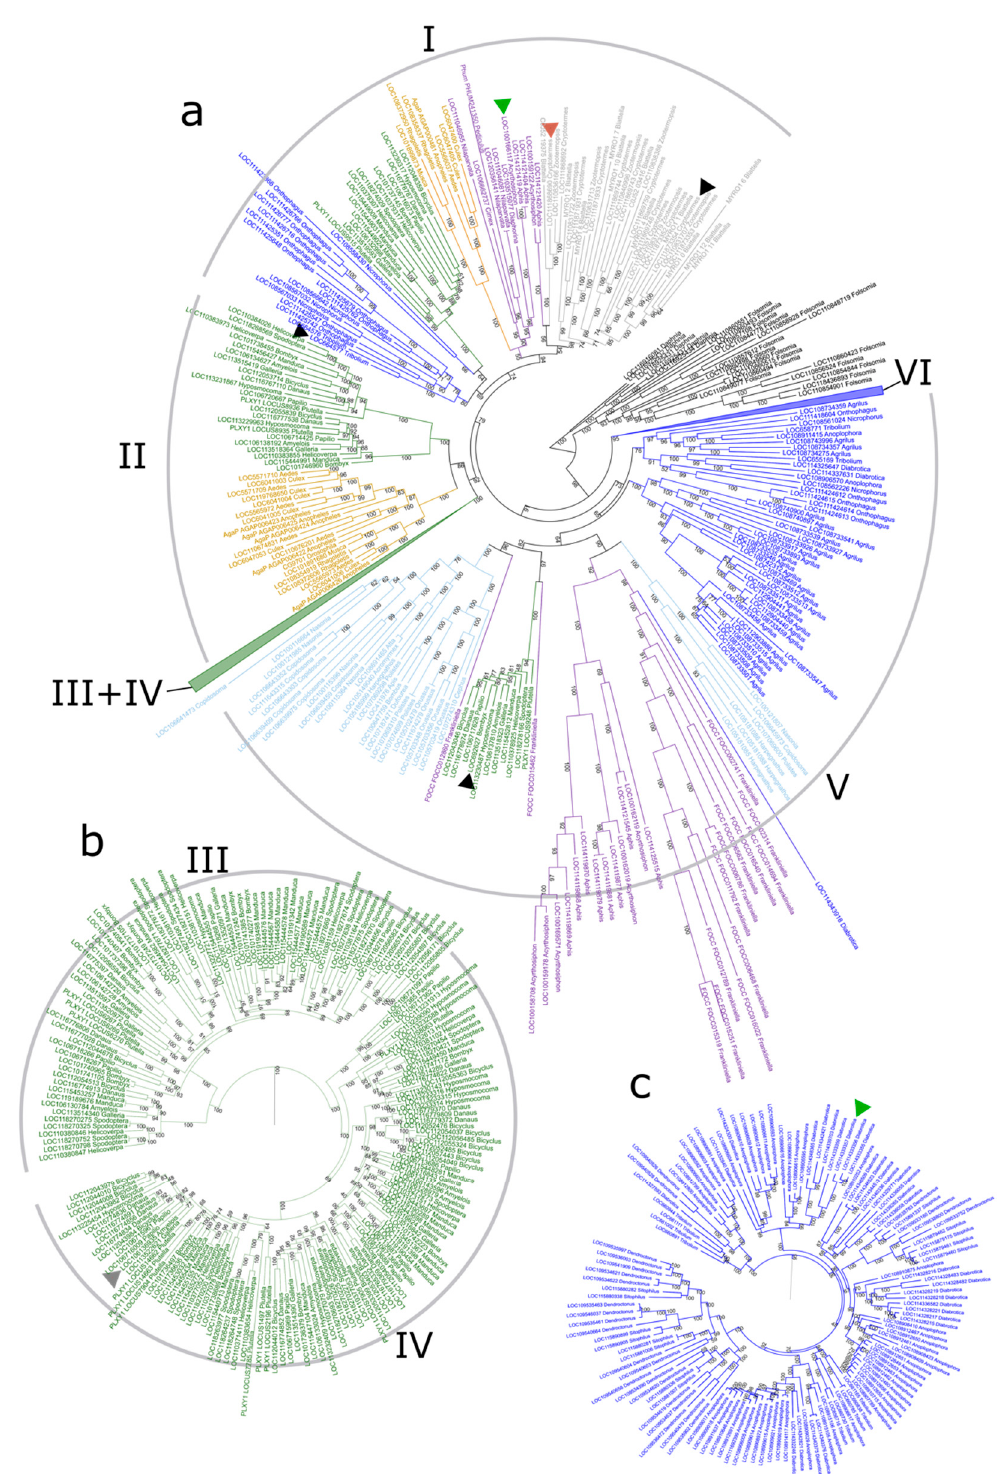
Figure 4. The phylogeny of identified GH1 genes built from proteins with IQTREE. The best blastp targets of characterized functional GH1s are marked in colored triangles. The GH1 gene trees were visualized using Interactive Tree Of Life (Letunic and Bork 2019). Digestive β -glucosidases ( (cid:78) ): LOC692627 Bombyx (AAP13852.1, blastp E-value: 0, (Byeon et al., 2005)); LOC111873352 Cryptoter- mes (AGS32242.1, blastp E-value: 0, (Franco Cairo et al., 2013)); LOC66457 Tribolium